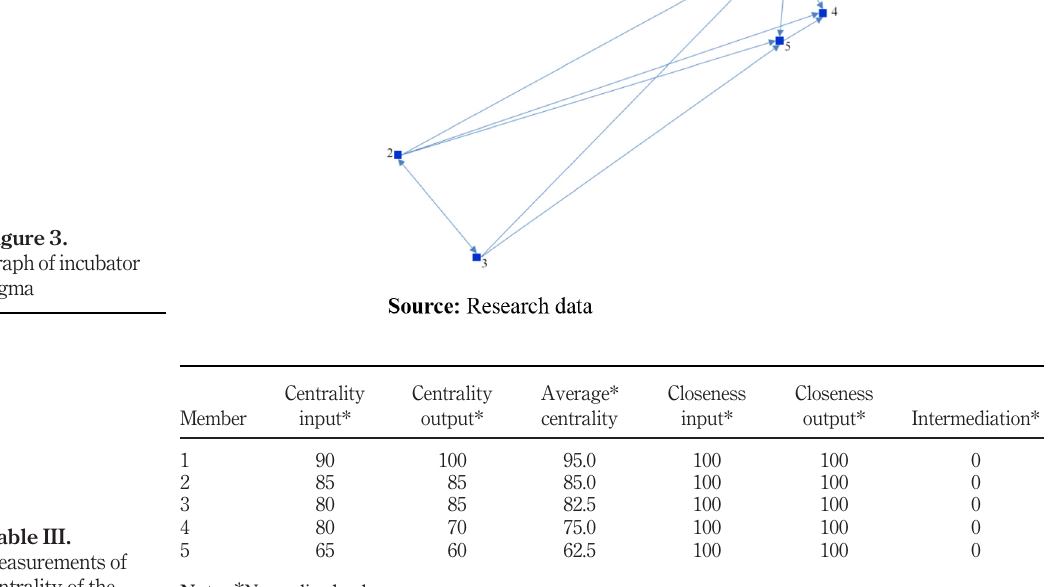
Table III. Measurements of centrality of the incubator Sigma